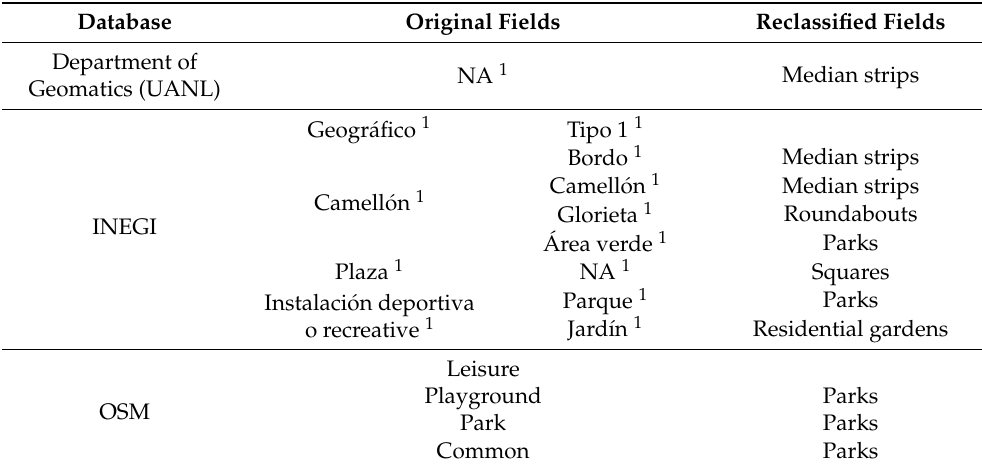
Table 1. Label reassignment on the reclassification process of the three databases.